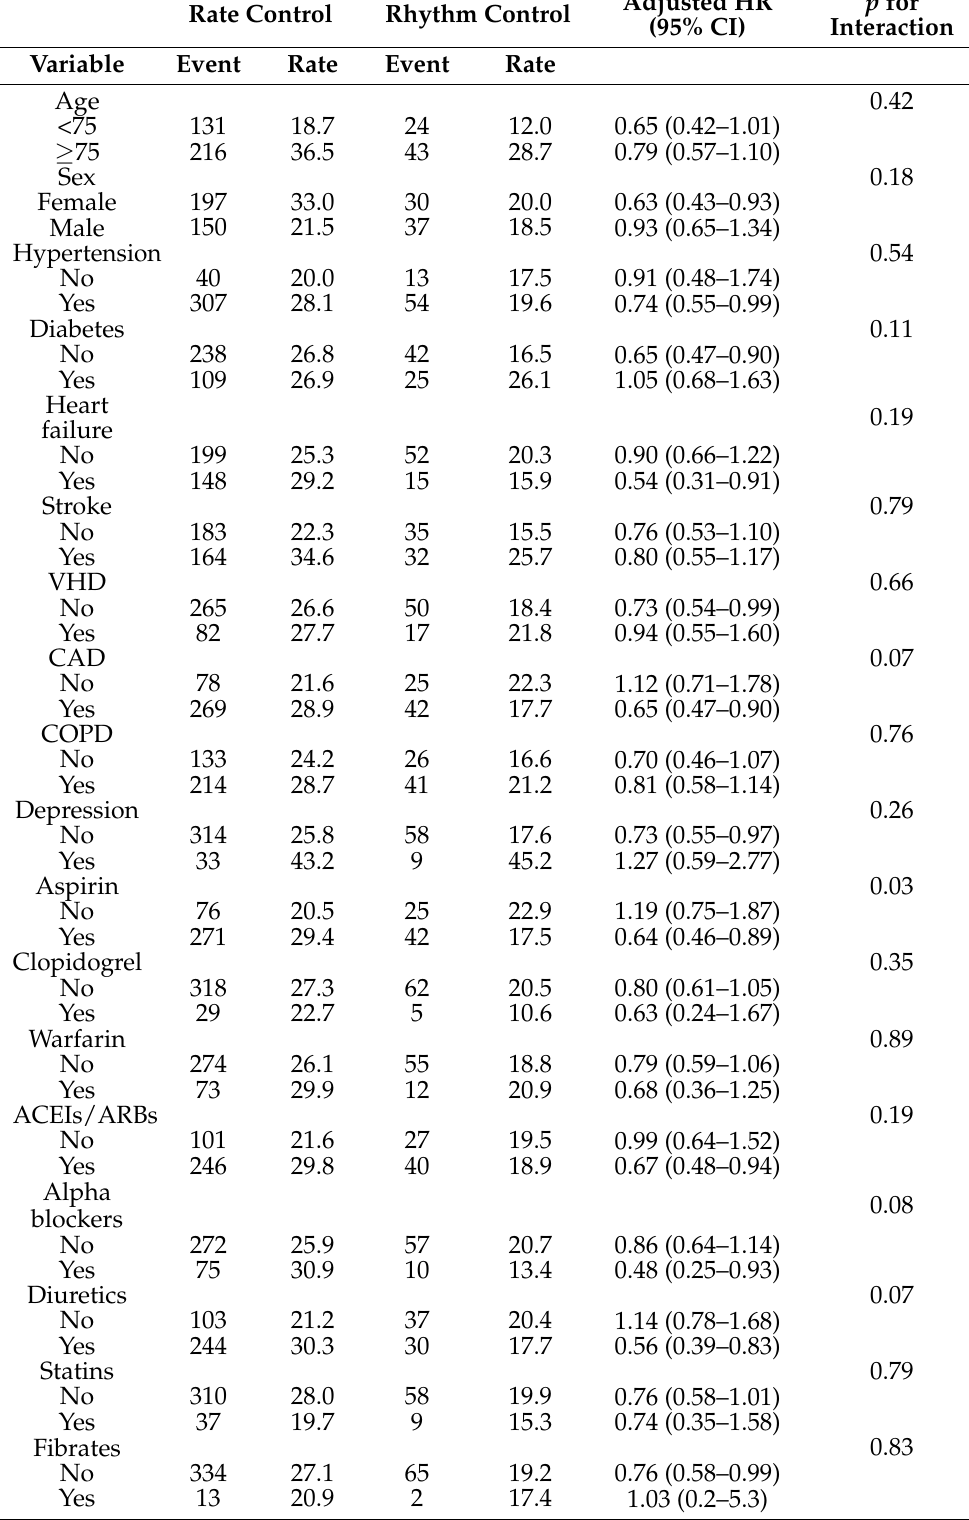
Table 4. Subgroup analysis of the hazard ratio for dementia in AF